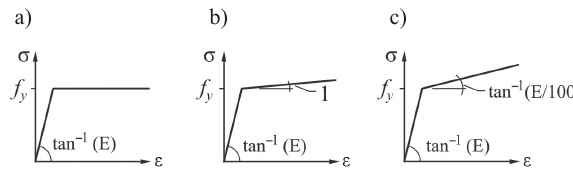
Fig. 3. Typical models of material behaviour (EN 1993-1-5 2006)